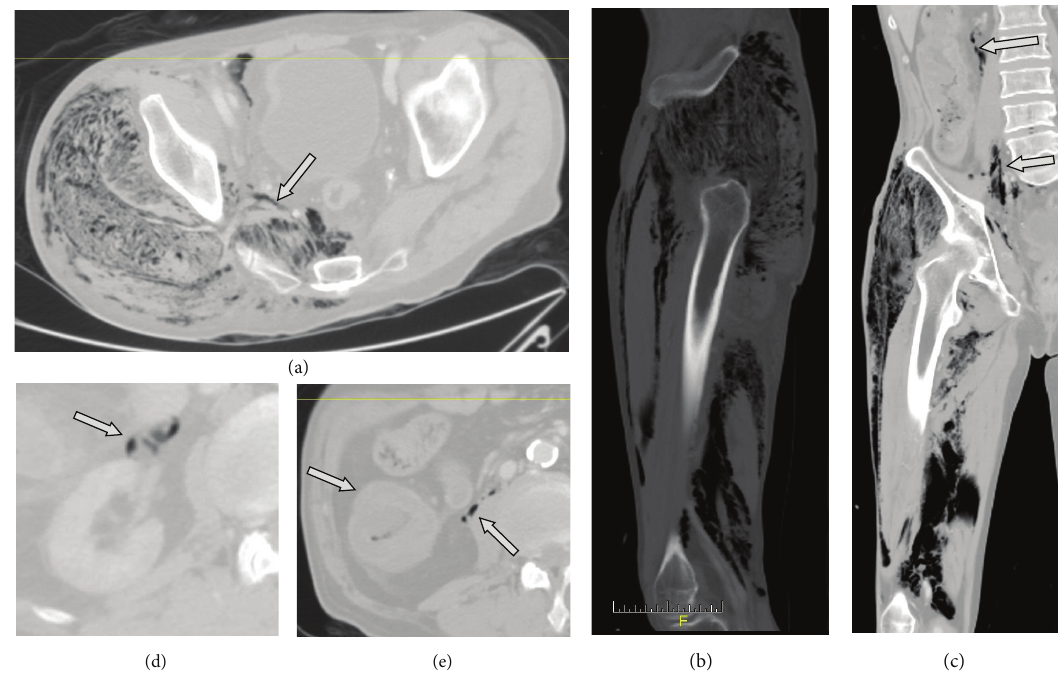
Figure 1: Preoperative CT scan. (a) shows an axial slice of the pelvis a little proximally from the acetabula with a massive infestation of the gluteal muscles and the intrusion of the infection into the retroperitoneal space in the true pelvis though the sciatic notch (arrow). (b) shows a sagittal reconstruction slice with extensive infestation of the whole circumference of the thigh. Gluteal musculature, the extensor muscles (quadriceps and rectus), and hamstrings are affected. (c) shows a coronary reconstruction with again massive affection of the thigh. It also indicates the disseminated infestation of the retroperitoneum with evidence of gas (arrows). (d) shows gas next to the vascular pedicle of the right kidney (arrow). (e) shows the thickened ascending colon (left arrow) and again retroperitoneal gas (right